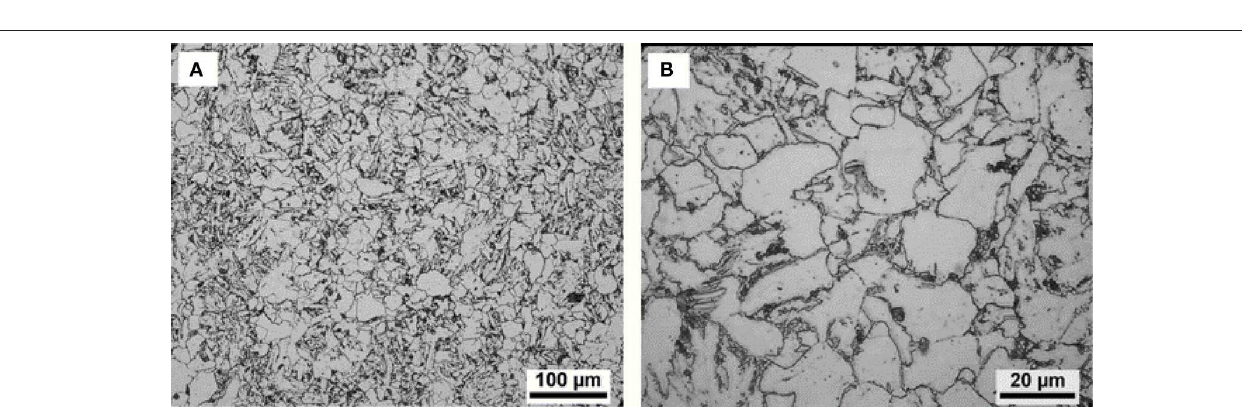
FIGURE 5 | Microstructure of CB10 steel, showing the grain size after HIC. (A) Test sample #1, (B) test sample #2.